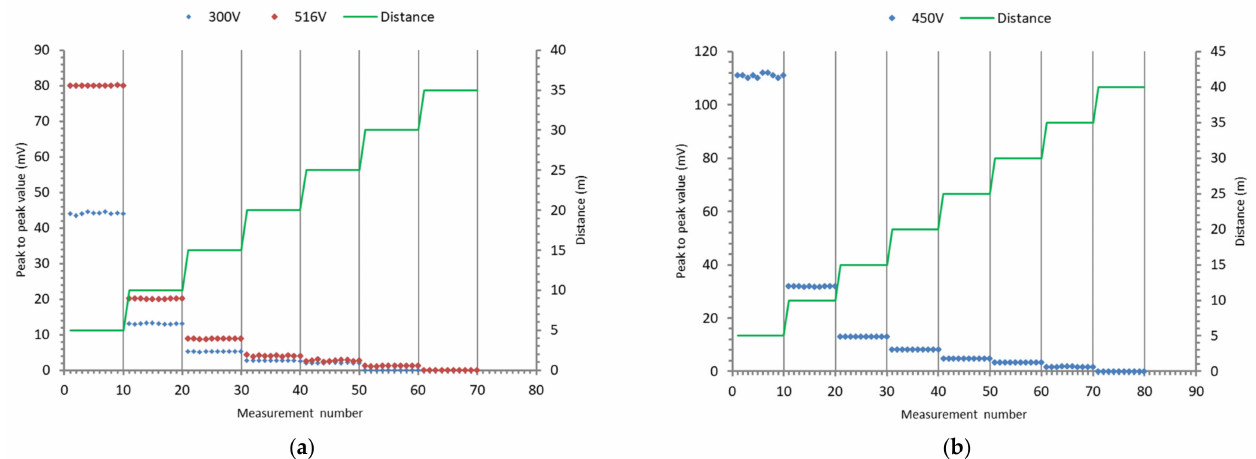
Figure 9. ( a ) Signal of voltage in the AR41 receiver at the V p-p voltage of the transmitter set to 300 V and 516 V; ( b ) Signal of voltage in the AR30 receiver at the V p-p voltage of the transmitter set to 450 V.